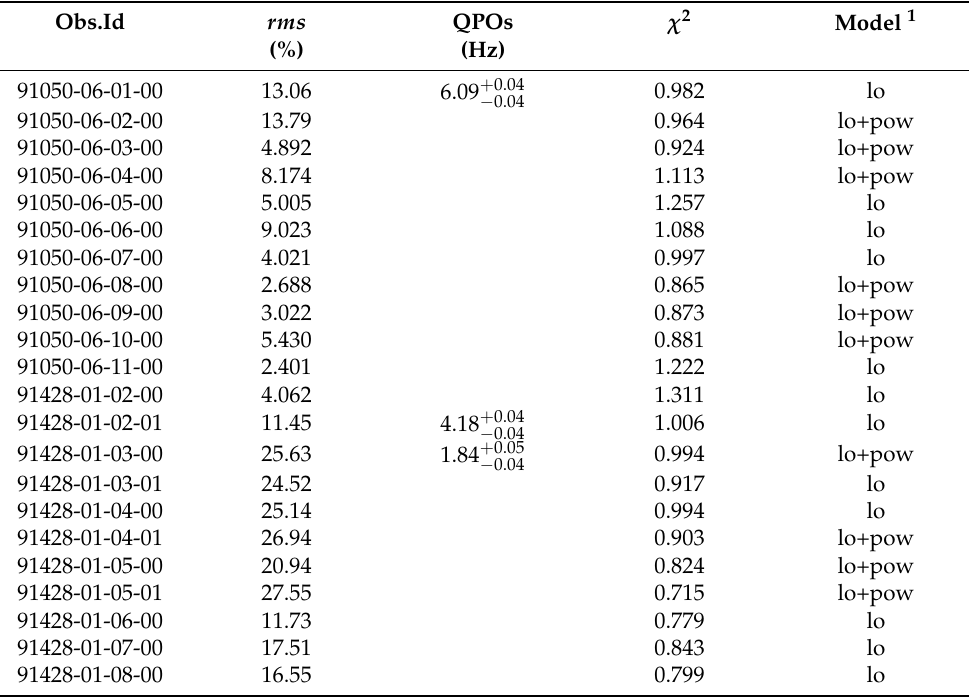
Table 2. The best fitting parameters of the timing of H 1743-322 during the “faint” 2005 outburst. Obs.Id rms QPOs χ 2 Model 1